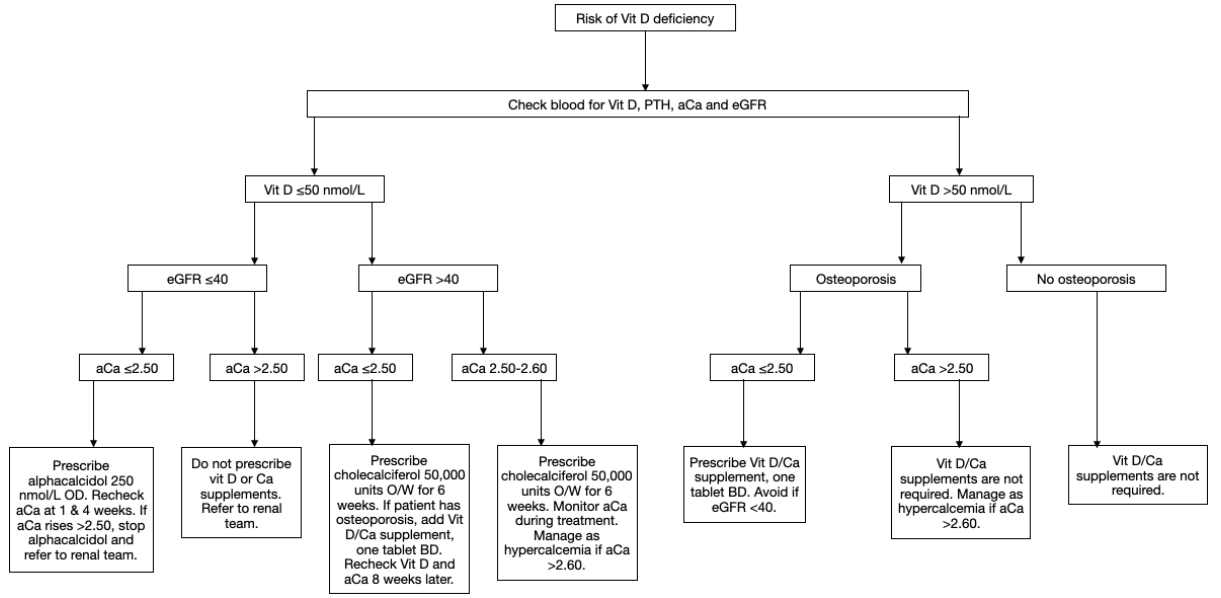
Figure 1. Assessment and management of patients with femoral neck fractures at risk of vitamin D deficiency, as described by the University Hospital of Coventry and Warwickshire guidelines. Vit D: vitamin D; eGFR: estimated glomerular filtration rate; PTH: parathyroid hormone; aCa: adjusted calcium, OD: once daily; O/W: once weekly; BD: twice daily.